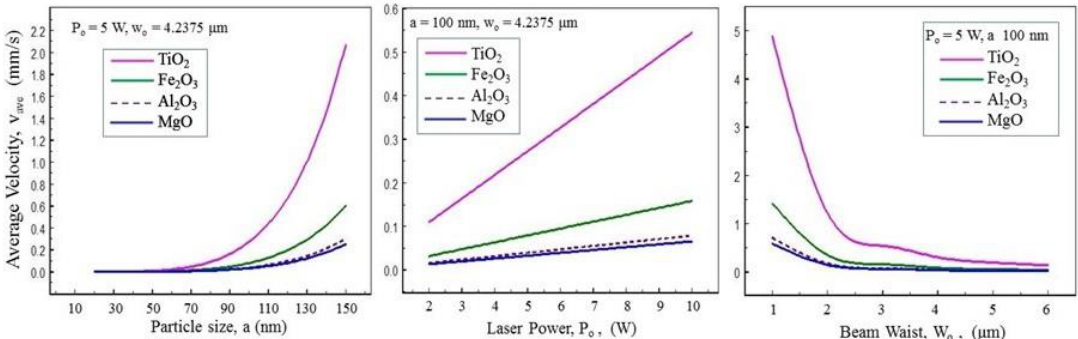
Figure 6. Effects of the laser power, P o , beam waist, W o , and particle size on the fluid average velocity (focal length = 75 mm, beam diameter d = 6 mm, λ = 532 nm ( w o = 4.2375 μm, Equation (8)), refractive index of water n f = 1.332, water viscosity μ f = 0.98 × 10 −3 kg/m-s, the particle is at the beam waist).